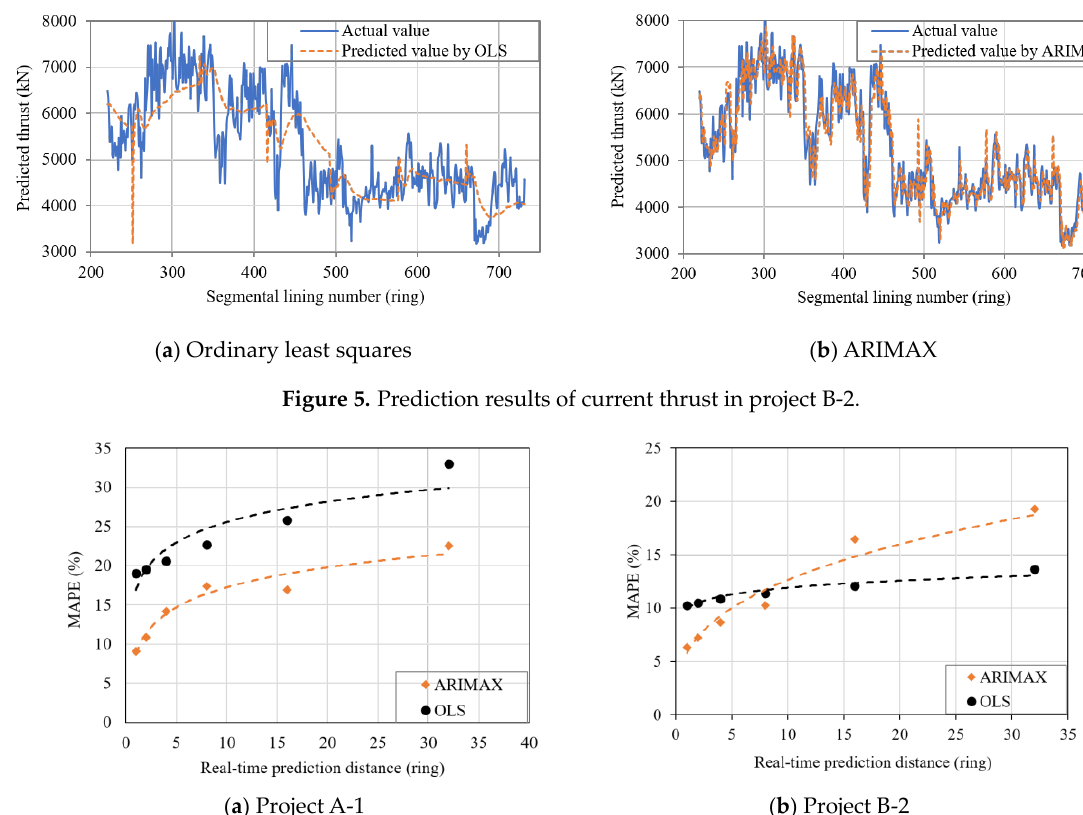
Figure 6. Prediction error for the stacked values of current thrust in projects A-1 and B-2 according to real-time prediction distance.